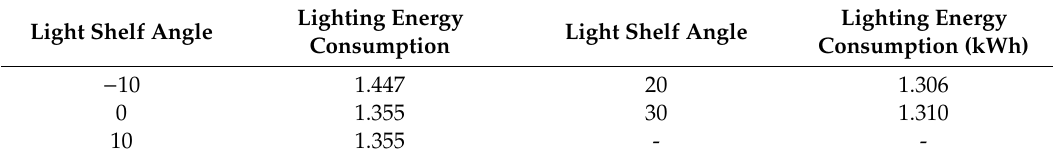
Table 12. Lighting energy consumption by fixed light shelf with an arc angle of 60 ◦